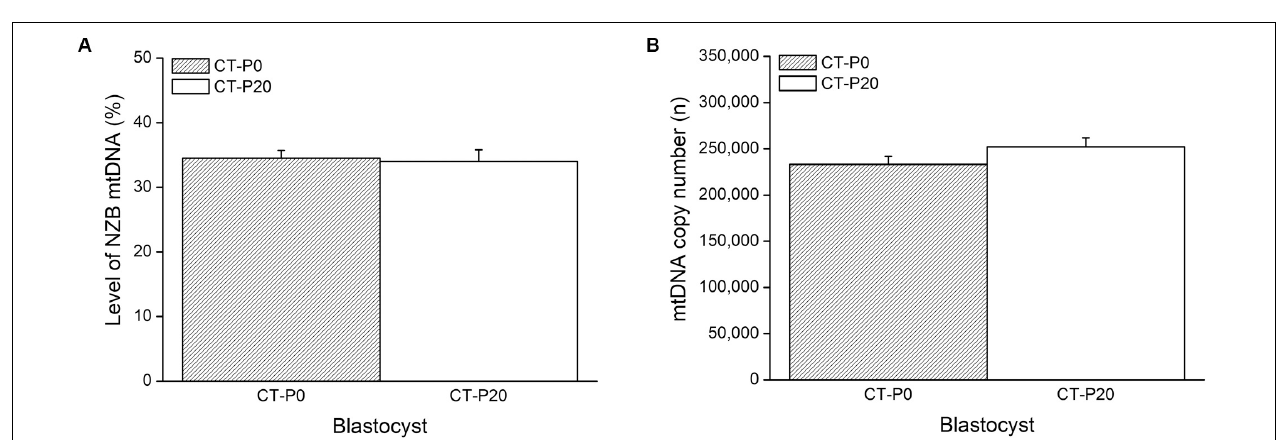
FIGURE 2 | Photoirradiated mitochondria injected into zygotes are selected against during early embryogenesis. CMXRos-loaded zygotes containing mtDNA of NZB origin were photoirradiated for either 0 (P0) or 20 (P20) s to induce mitochondrial damage. Mitochondria from these zygotes were injected by cytoplasmic transfer (CT) into B6 zygotes, resulting in CT-P0 and CT-P20 groups, respectively. CT-derived embryos were assessed at zygote and blastocyst stage as for the levels of NZB (A) and total (B) mtDNA. Different letters over bars depict statistical difference within group ( P < 0.05). *Statistical difference within stage ( P = 0.008).